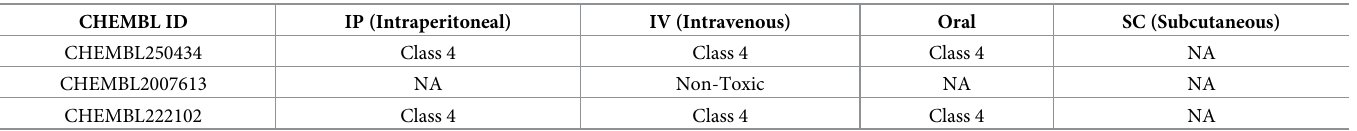
Table 4. Citotoxicity predicted by